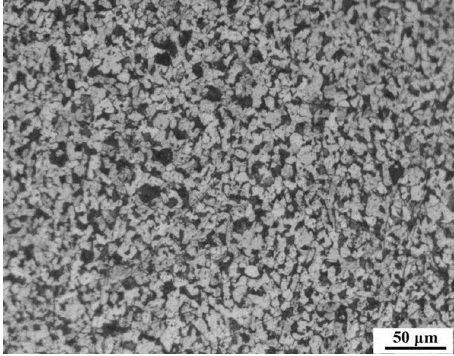
Figure 1. Metallographic micrograph of HRB400 steel.